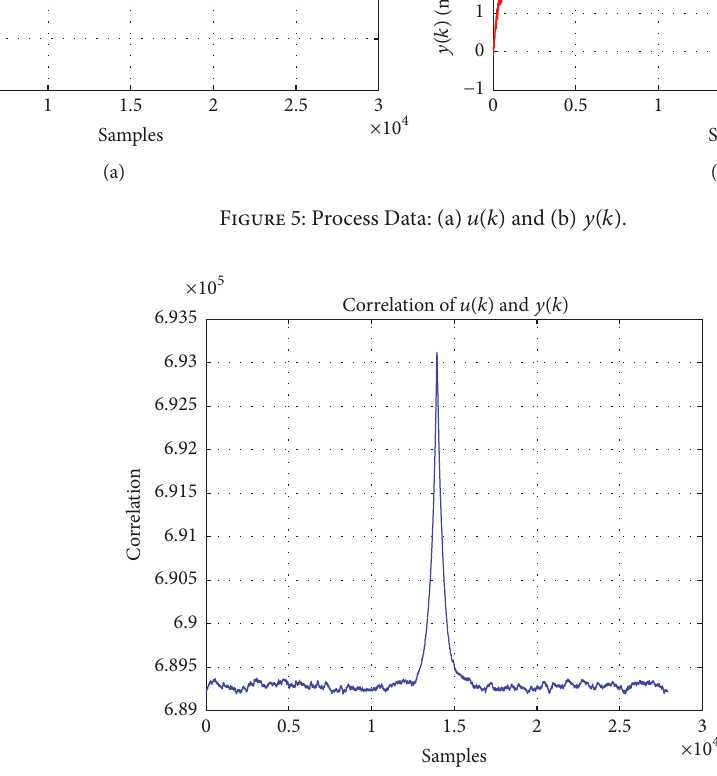
Figure 6: The cross-correlation function for the data set.